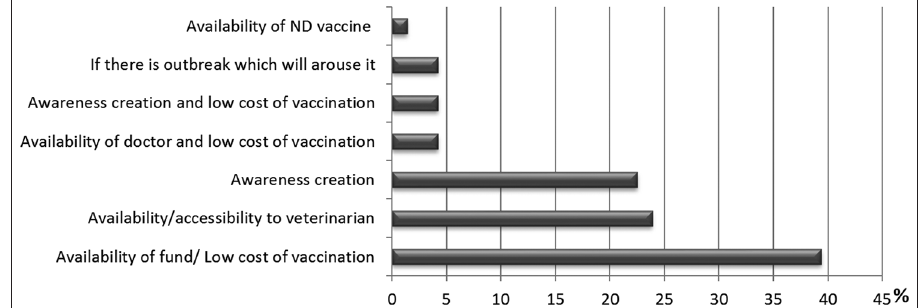
Figure-3: Factor(s) that support the feasibility of vaccination against Newcastle disease virus at least every 6 months.